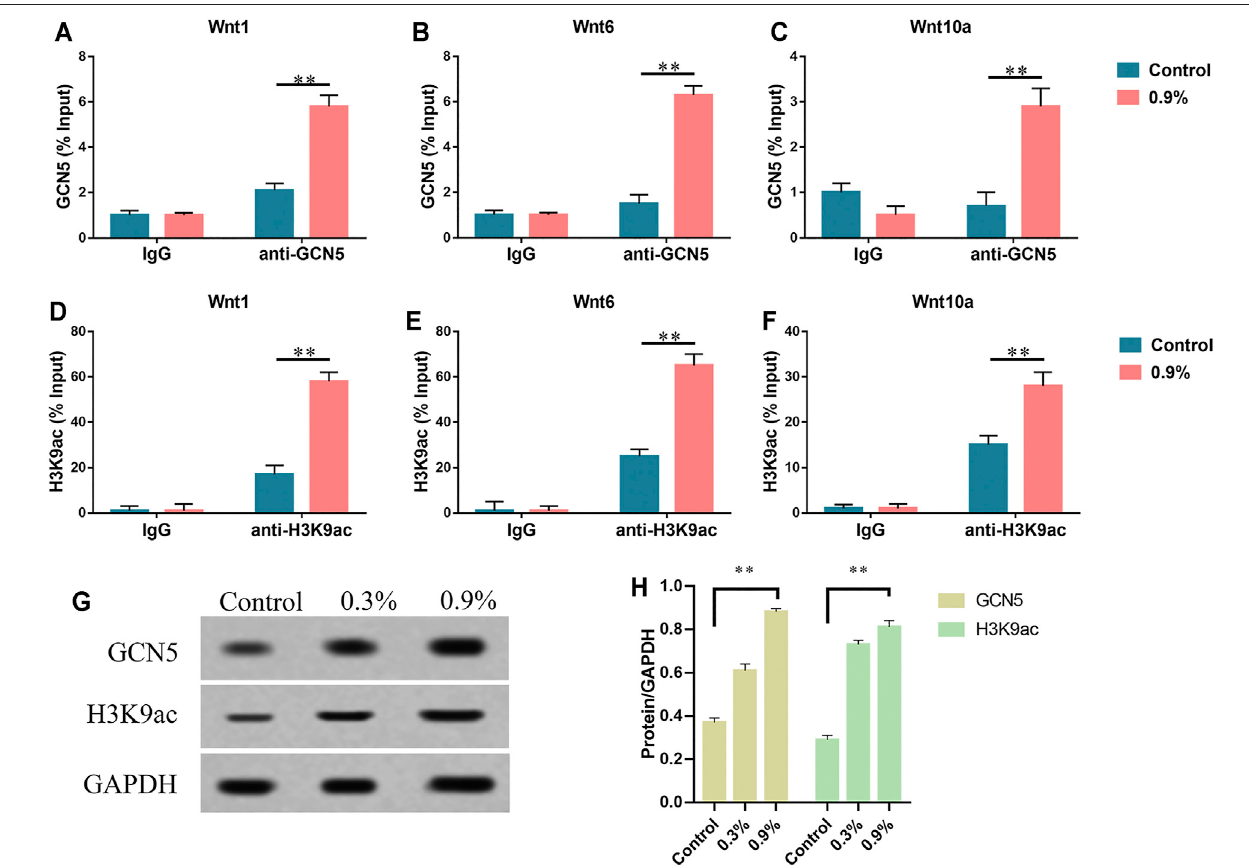
FIGURE 4 | Histone acetyltransferase GCN5 is increased due to mechanical strain. (A – C) The ChIP assay was performed to evaluate the combination of GCN5 andIgGtoWnt1,Wnt6,andWnt10apromotersinBMSCswhichwereexposedtomechanicalstrain. (D – F) TheChIPassaywasperformedtoevaluatetheenrichmentof H3K9ac and IgG to Wnt1, Wnt6, and Wnt10a promoter regions. (G) Western blots of GCN5 and H3K9ac after 7 days of treatment. GAPDH is shown as the loading control. (H) Semi-quantitative and statistical analyses of the results in Panel G. Values are plotted as mean ± SD, * p < 0.05, ** p <